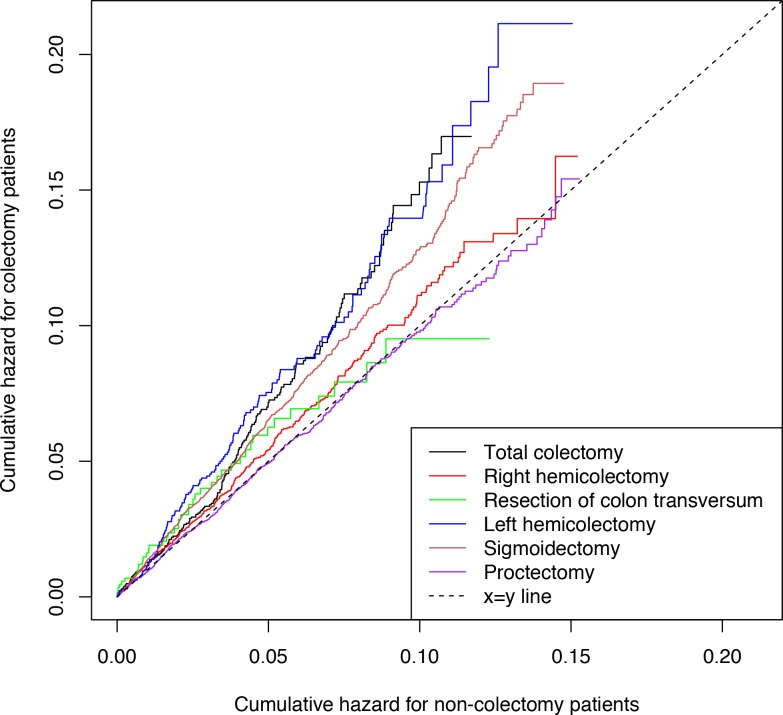
Cumulative hazards of clinically recorded type 2 diabetes.Cumulative hazards are presented for patients with total colectomy, right hemicolectomy, resection of colon transversum, left hemicolectomy, sigmoidectomy, and proctectomy and for non-colectomy patients. Total colectomy includes colectomy and proctocolectomy. The cumulative hazard was estimated using the Nelson-Aalen estimator. The slopes of the curves equalize the hazard ratios: a slope of 1.00 corresponds to a hazard ratio of 1.00, whereas a slope >1 implies that colectomy patients have a higher risk of type 2 diabetes compared with non-colectomy patients. The linearity attests to the fulfillment of the assumption of proportional hazards in the Cox regression models.